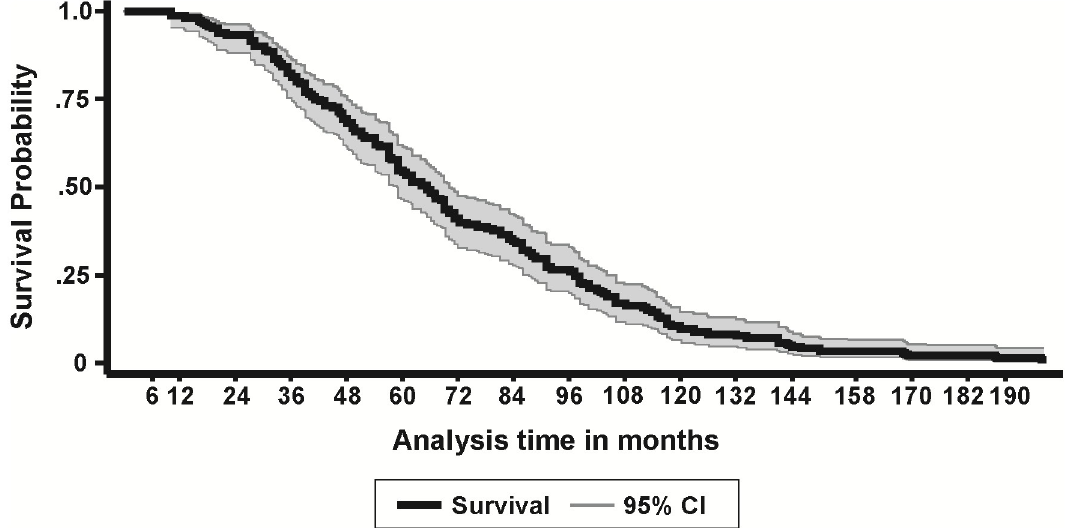
Fig 2. Time to confirmed VTF. Kaplan Meier cumulative probability of VTF following ART initiation at different time intervals, n = 160.